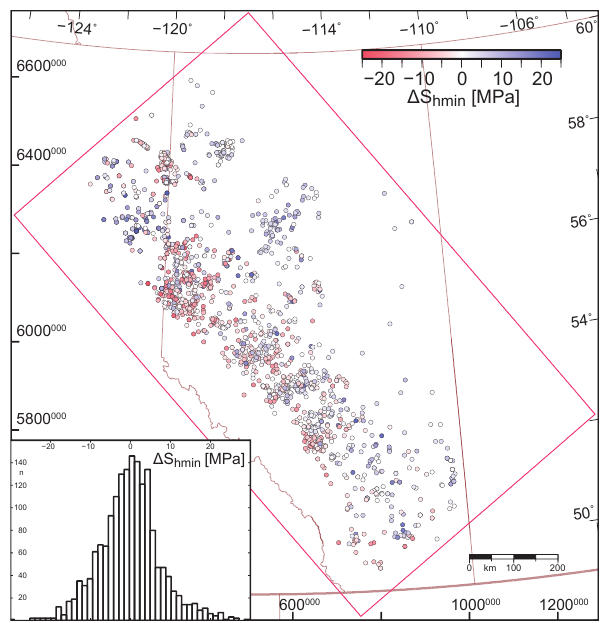
Figure 18. Comparison of the modelled and in situ S hmin magni- tudes, plotted as (cid:49)S hmin . The map extent is indicated by geograph- ical coordinates (top and right) and by UTM coordinates from zone 11 (left and